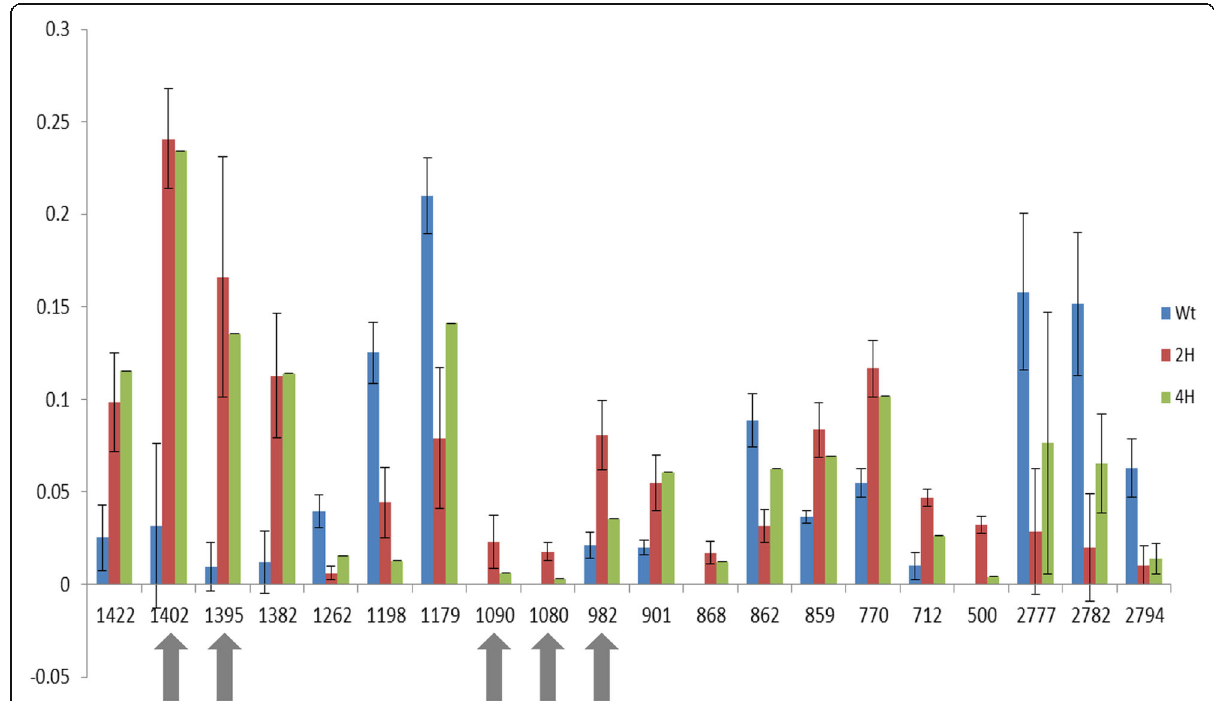
Fig. 4 Graphic represents an intensity comparison of the representative samples of spots detected in 2-D gels of untreated K1 plants (blue), treated at 45 °C for 2 h (red) and 4 h (green). Grey arrows indicate spots that are isolated for protein